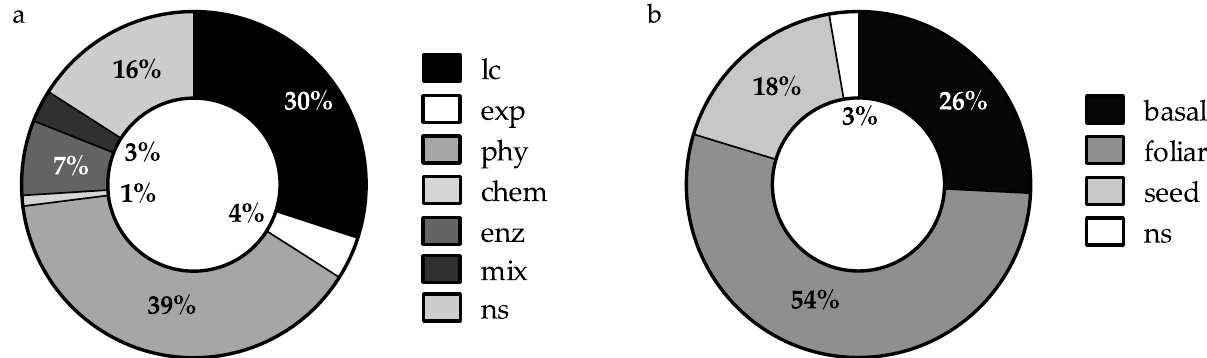
Figure 2. Cyanobacteria processing methods ( a ) and methods of application to plants ( b ) in the papers found through bibliometric analysis. The graphs represent the distribution (%) of publications in the period under review (2006–2020). lc, living cells; exp, released extracellular products; phy, biomass physical extraction; chem, biomass chemical extraction; enz, biomass enzymatic extraction; mix, mixed extraction (physical and chemical); basal, basal application; foliar, foliar spraying; seed, seed coating; ns, not specified.